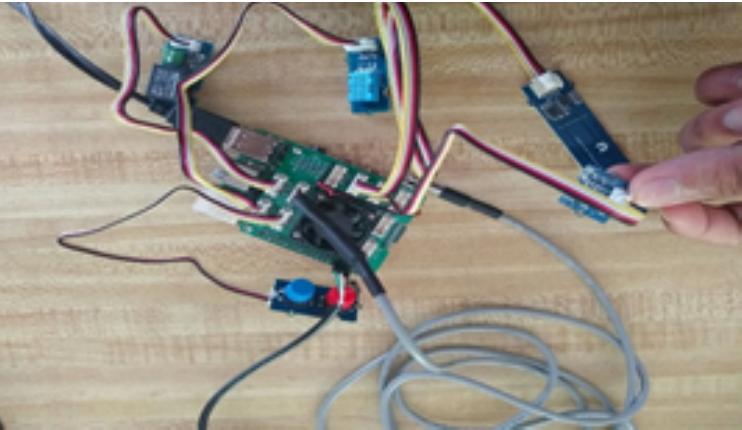
Figure 2. Mosquito edge framework configured with sensors and